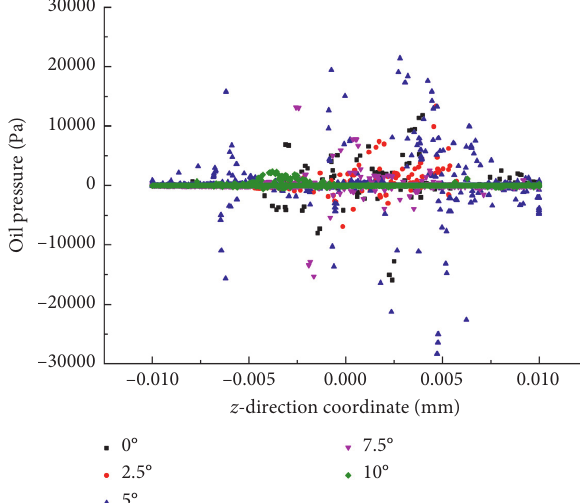
Figure 7: Oil pressure distribution in the tooth width direction.